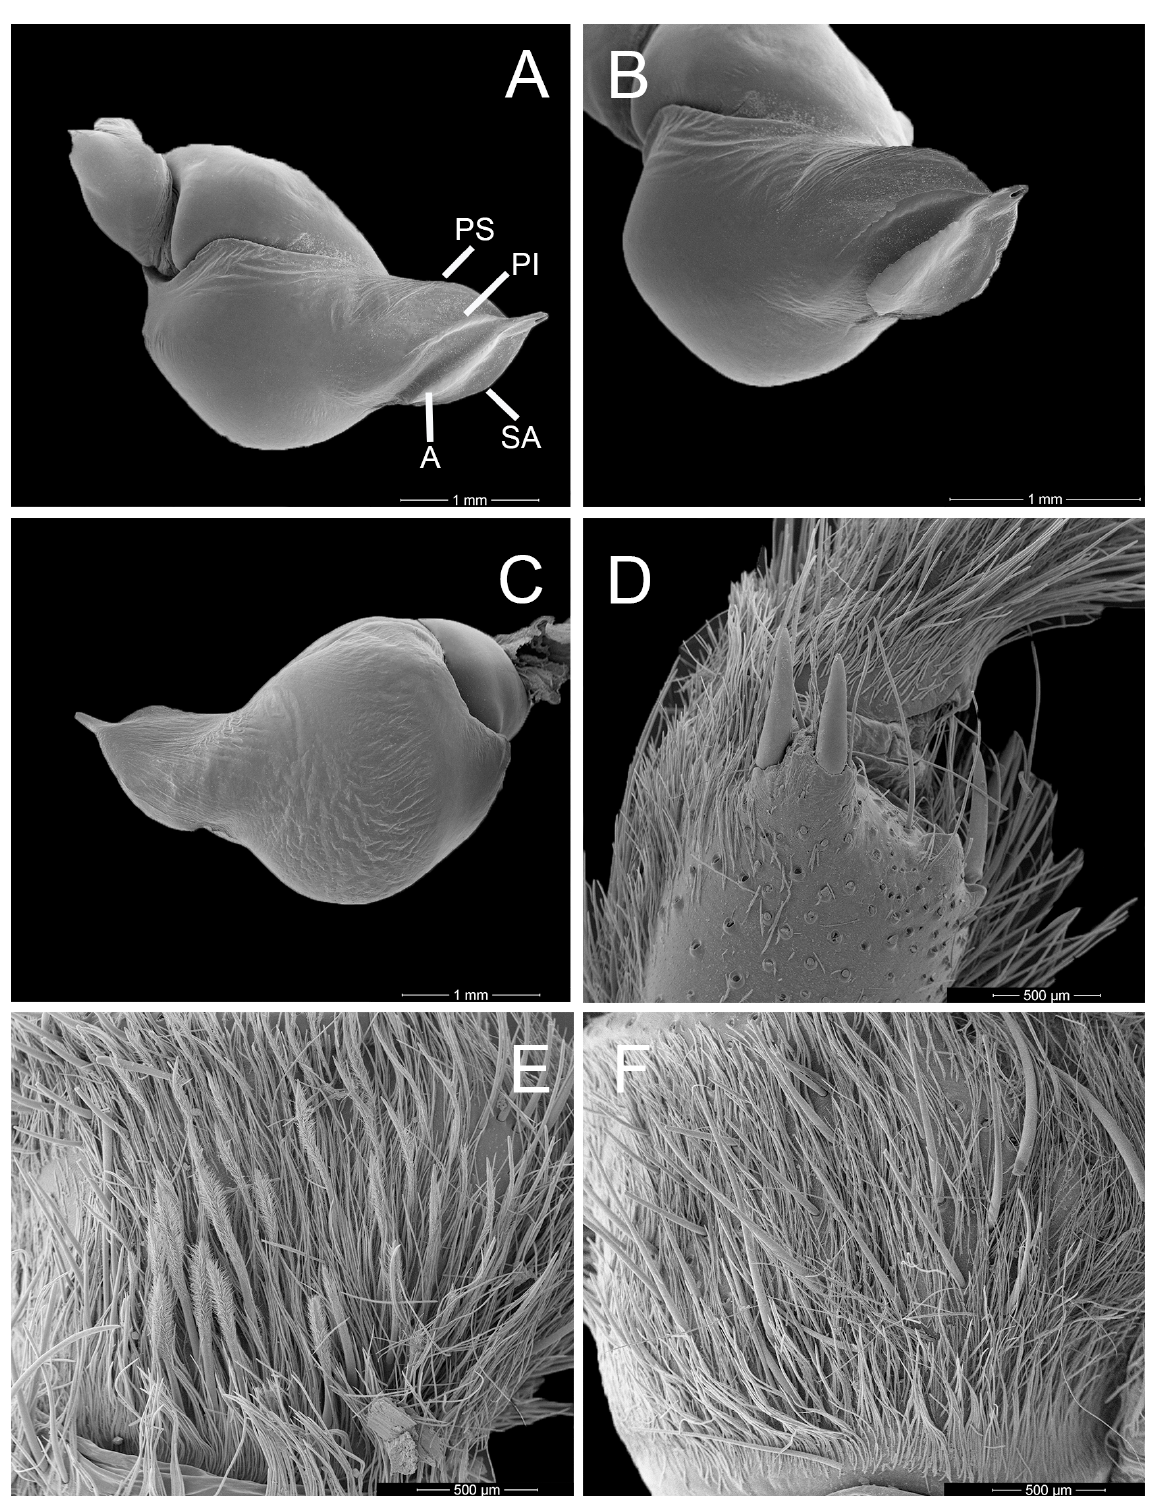
Fig. 17. Umbyquyra cuiaba gen. et sp. nov., holotype, ♂, Cuiabá, Mato Grosso, Brazil (IBSP 167423). A . Palp, prolateral. B . Anterolateral. C . Retrolateral. D . Tibial apophysis, retrolateral. E . Stridulatory organ, palp trochanter. F . Trochanter I. Abbreviations: see Material and